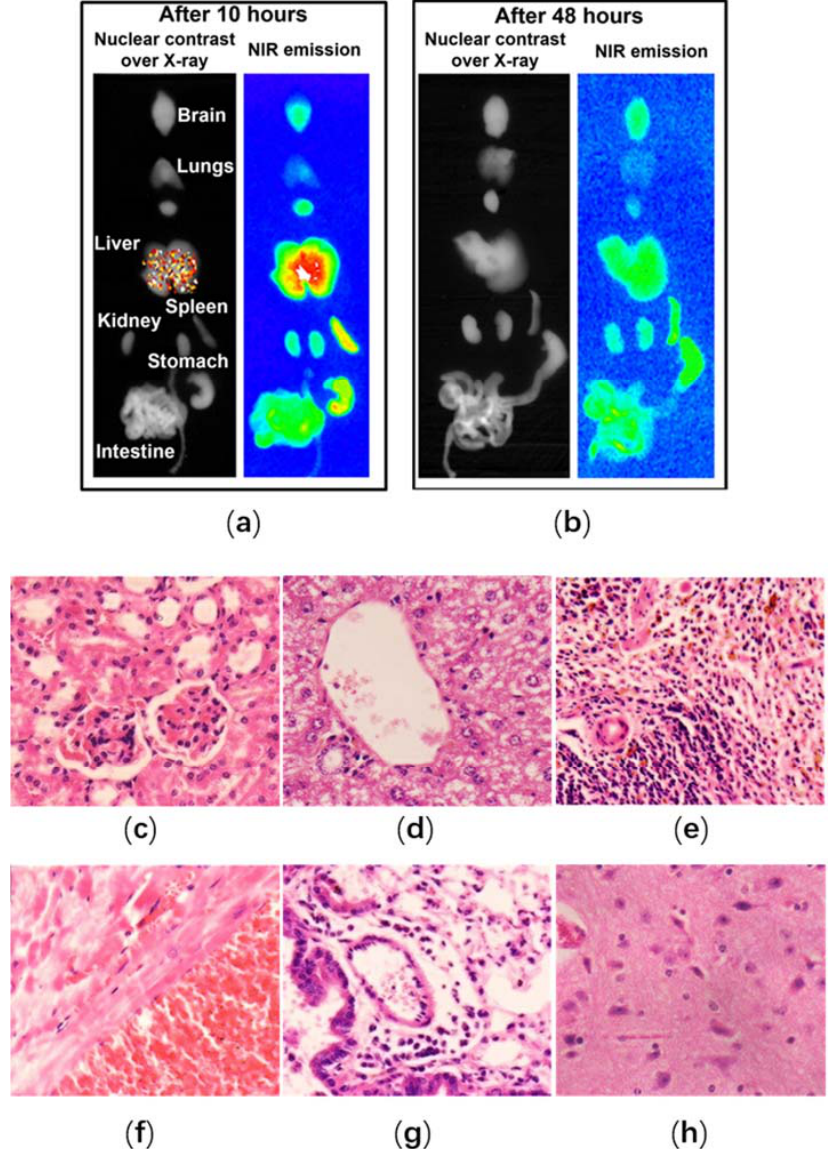
Figure 4. Biodistribution of ICG-loaded nanoparticles with surface modifications of polymers. Ex-vivo imaging of the major organs of mice: ( a ) 10 h after PEG-multifunctional-calcium phosphate nanoparticles (MF-nCP) injection; ( b ) 48 h after sample injection. Histological analysis of major organs as ( c ) kidney, ( d ) liver, ( e ) spleen, ( f ) heart, ( g ) lungs and ( h ) brain from mice after 48 h of sample injection at 40 × magnification showing no changes in the cellular integrity or tissue morphology. Reproduced from Ref. [53], with permission from Elsevier,